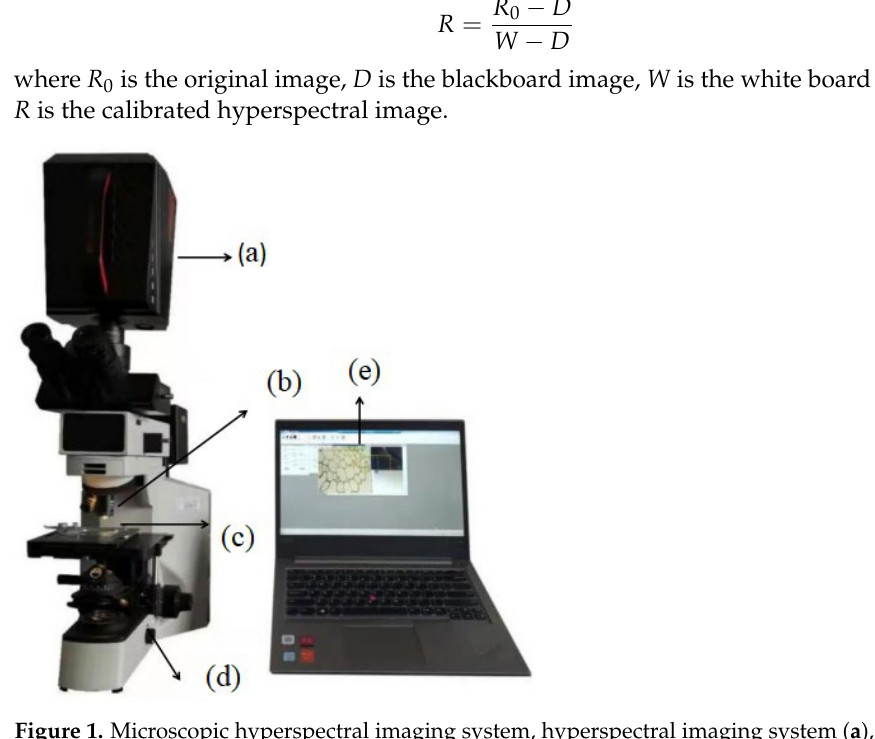
Figure 1. Microscopic hyperspectral imaging system, hyperspectral imaging system ( a ), microscopic objective ( b ), loading platform ( c ), light source control ( d ), computer acquisition software ( e ).